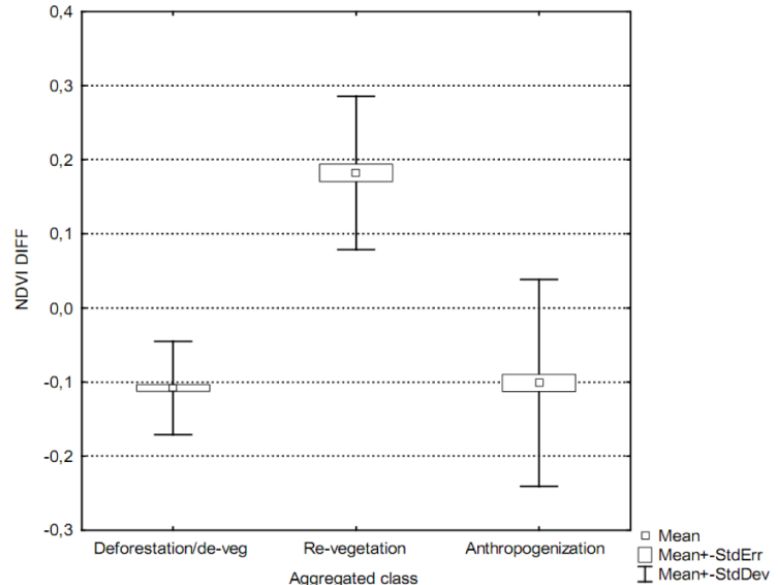
Figure 3. Differentiation of aggregated classes using NDVI.